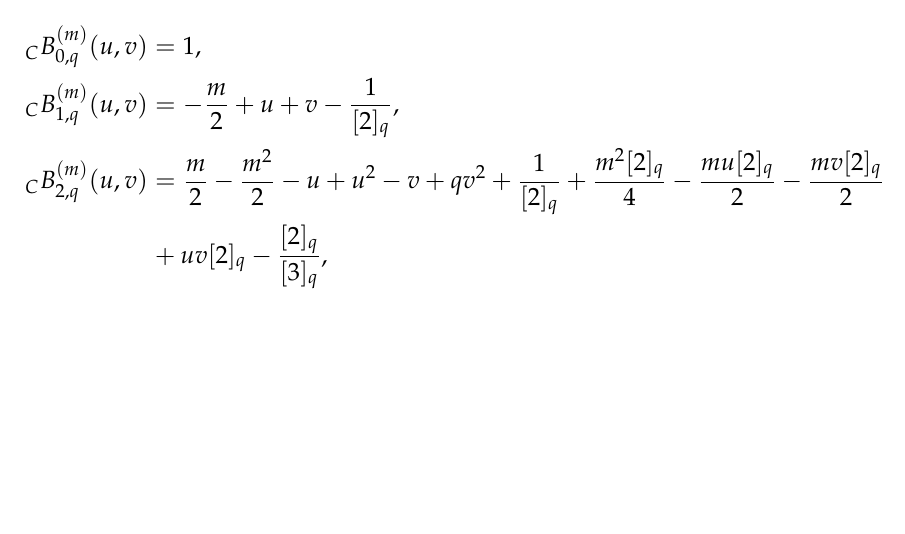
Table 4. Identities involving q GTBP C B